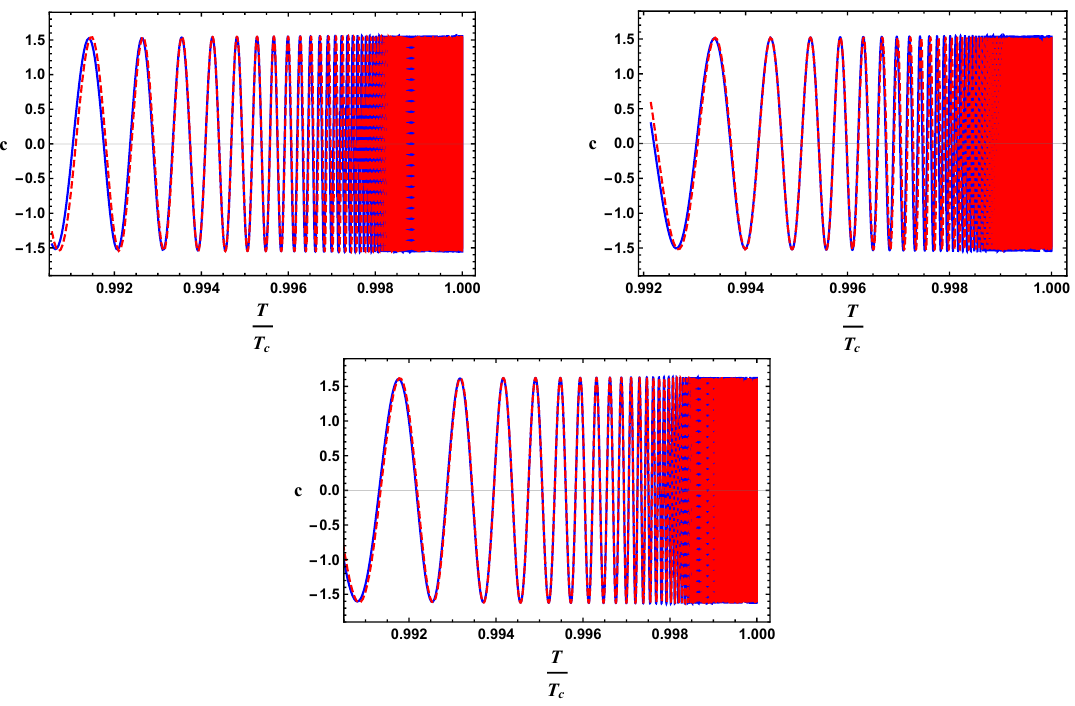
−√ Figure 6 . The oscillatory behavior of c = 8 d 3 /π determining the Kasner exponents as T → T c . The solid blue lines are the numerical data and the red dashed curves are fits to the relation (4.5). From top to bottom, panels are associated with the massive configuration β = 3 α = − 0 . 2 , β = 0 , α = − 2 and β = − 2 , α = 0 , respectively. Here we have taken T/T c = 0 . 995 and κ/µ = 1